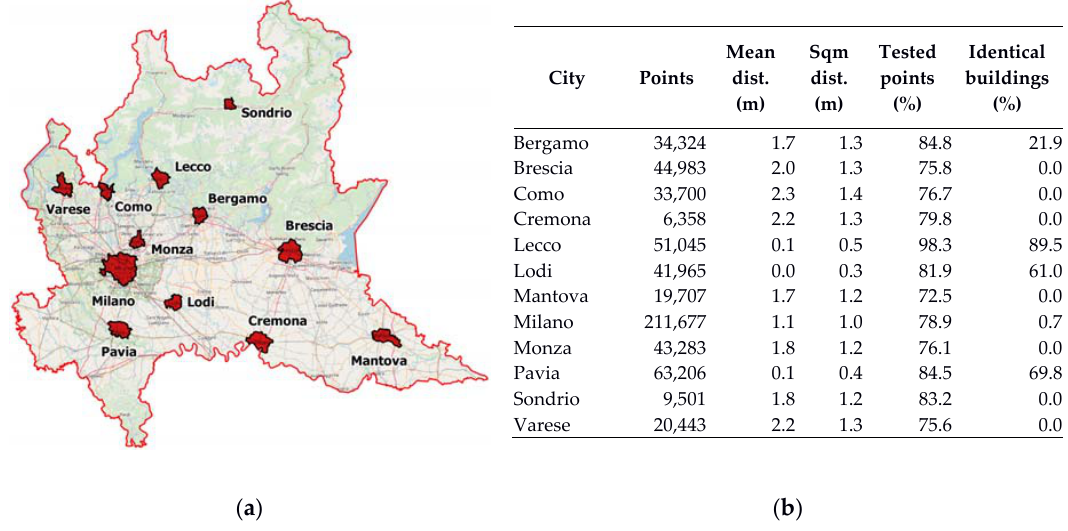
Figure 8. ( a ) Provincial capitals of the Lombardy region; ( b ) homologous points statistics for each capitals.